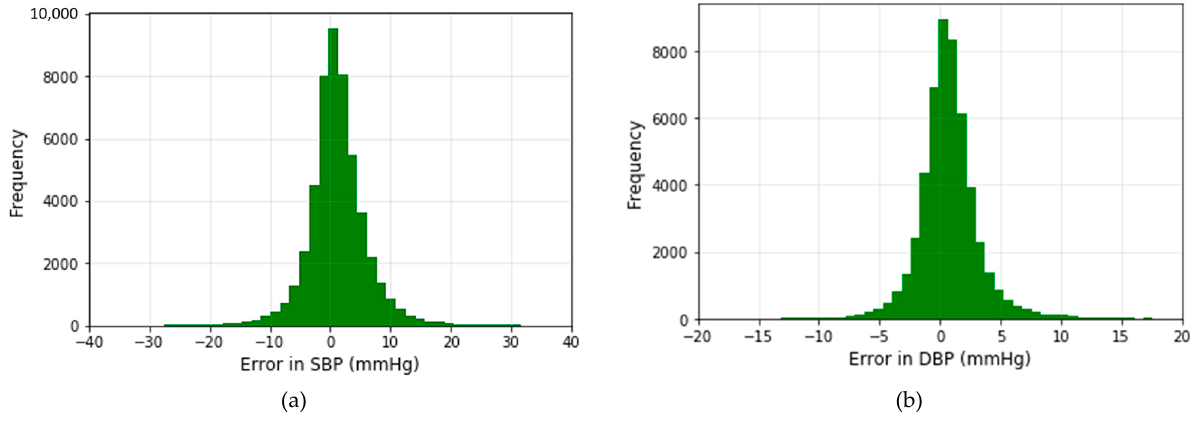
Figure 11. Error histograms of predicted ( a )SBP and ( b )DBP